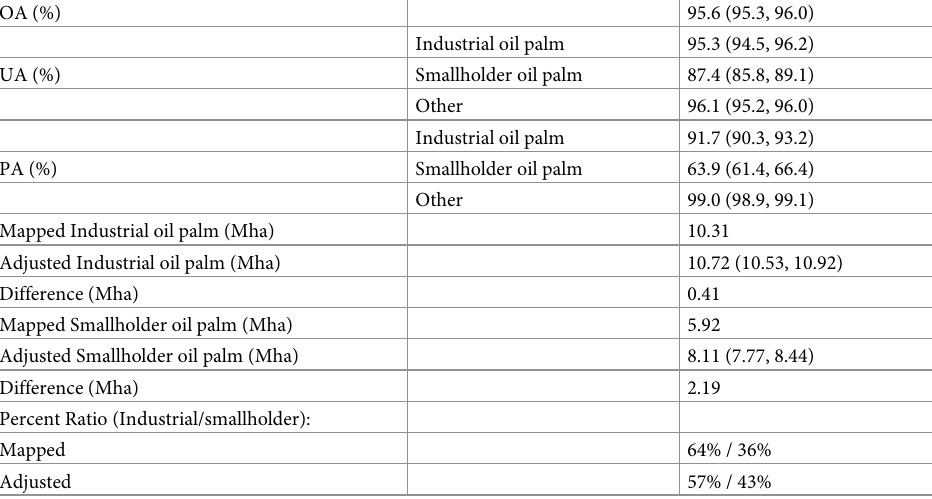
Table 3. Accuracy assessment of the Indonesia-wide 2019 oil palm plantation extent. The accuracy metrics were estimated with an initial total of 3,340 reference sites randomly distributed using stratified sampling in non-forest areas and below 500 m asl. The reported metrics are: 1) the overall accuracy (OA), the user’s accuracy (UA), and the produc- er’s accuracy (PA) with their 95% confidence intervals, and 2) the mapped oil palm extent (industrial and smallholder) and the adjusted extent with their 95% confidence